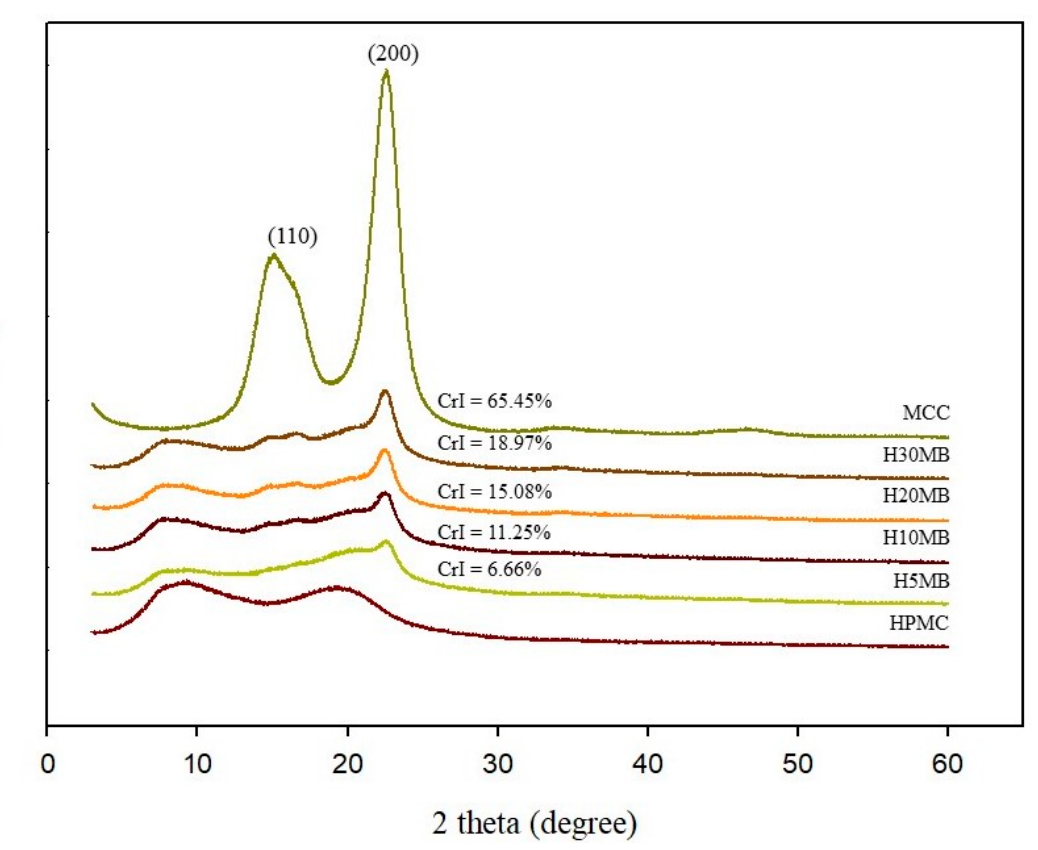
Figure 3. X-ray diffraction spectra of the hydroxypropyl methylcellulose (HPMC), 5% microcrystalline cellulose (MCC) (H5MB), 10% MCC (H10MB), 20% MCC (H20MB), and 30% MCC (H30MB) films.